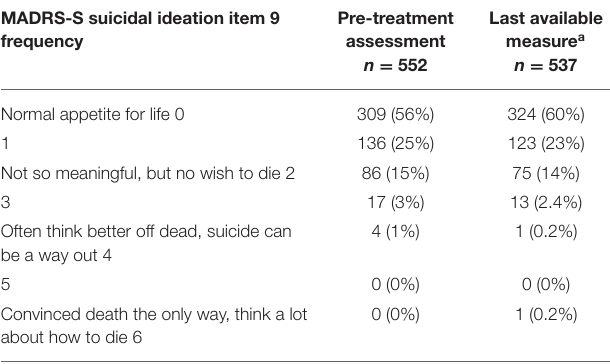
TABLE 3 | Frequencies of scores for the MADRS-S suicidal ideation